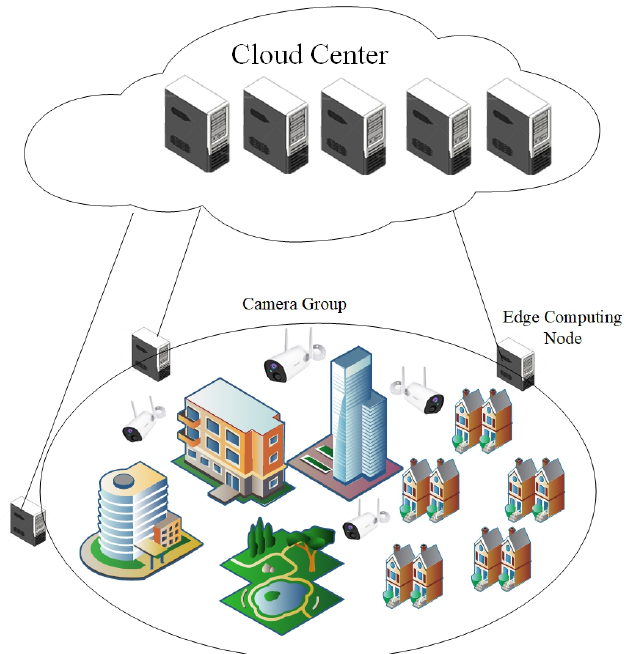
Figure 1. Computation offloading scenario comprising multiple video monitoring devices, multiple edge computing nodes, and a cloud data center. The video analysis data can be offloaded from local monitoring devices to an edge computing node and thereafter to the cloud data